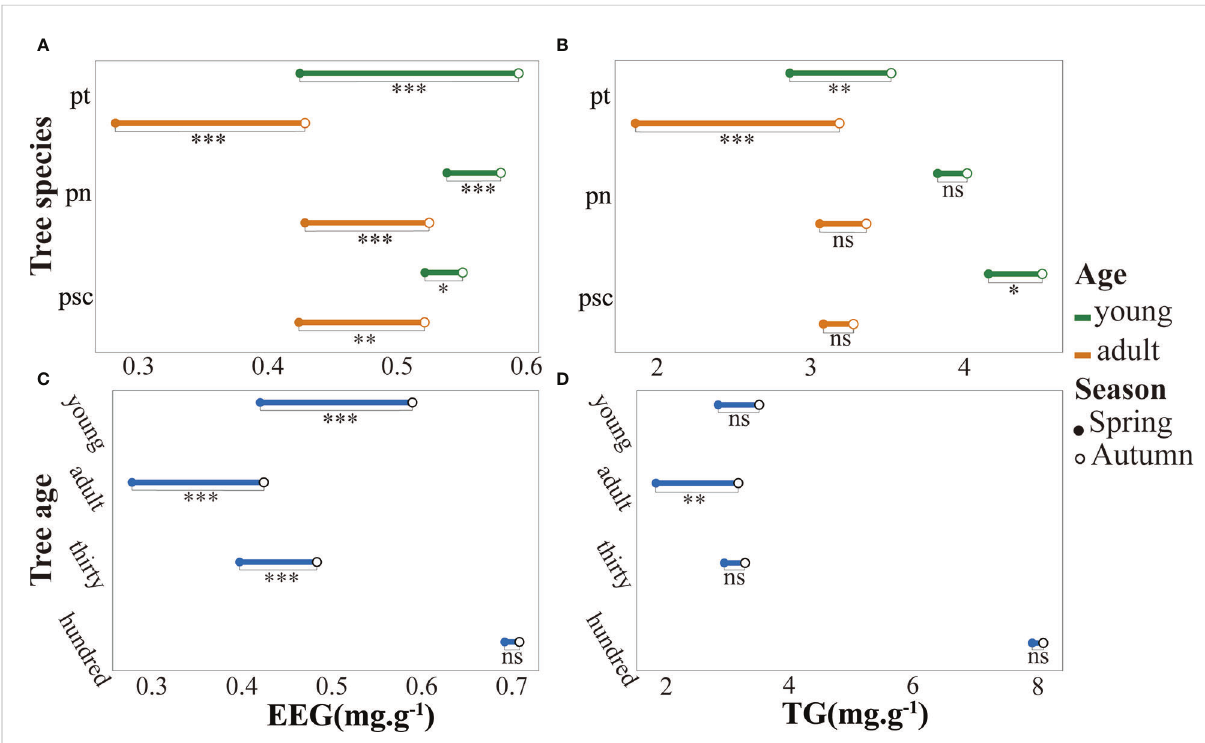
FIGURE 1 Glomalin-related soil protein (GRSP) contents in poplar rhizosphere soil. a. The EEG contents in Populus tomentosa , Populus nigra , and Populus simonii. b. The TG contents in P. tomentosa , P. nigra , and P. simonii . c. The EEG contents in rhizosphere soil of young, adult, 30-year-old,